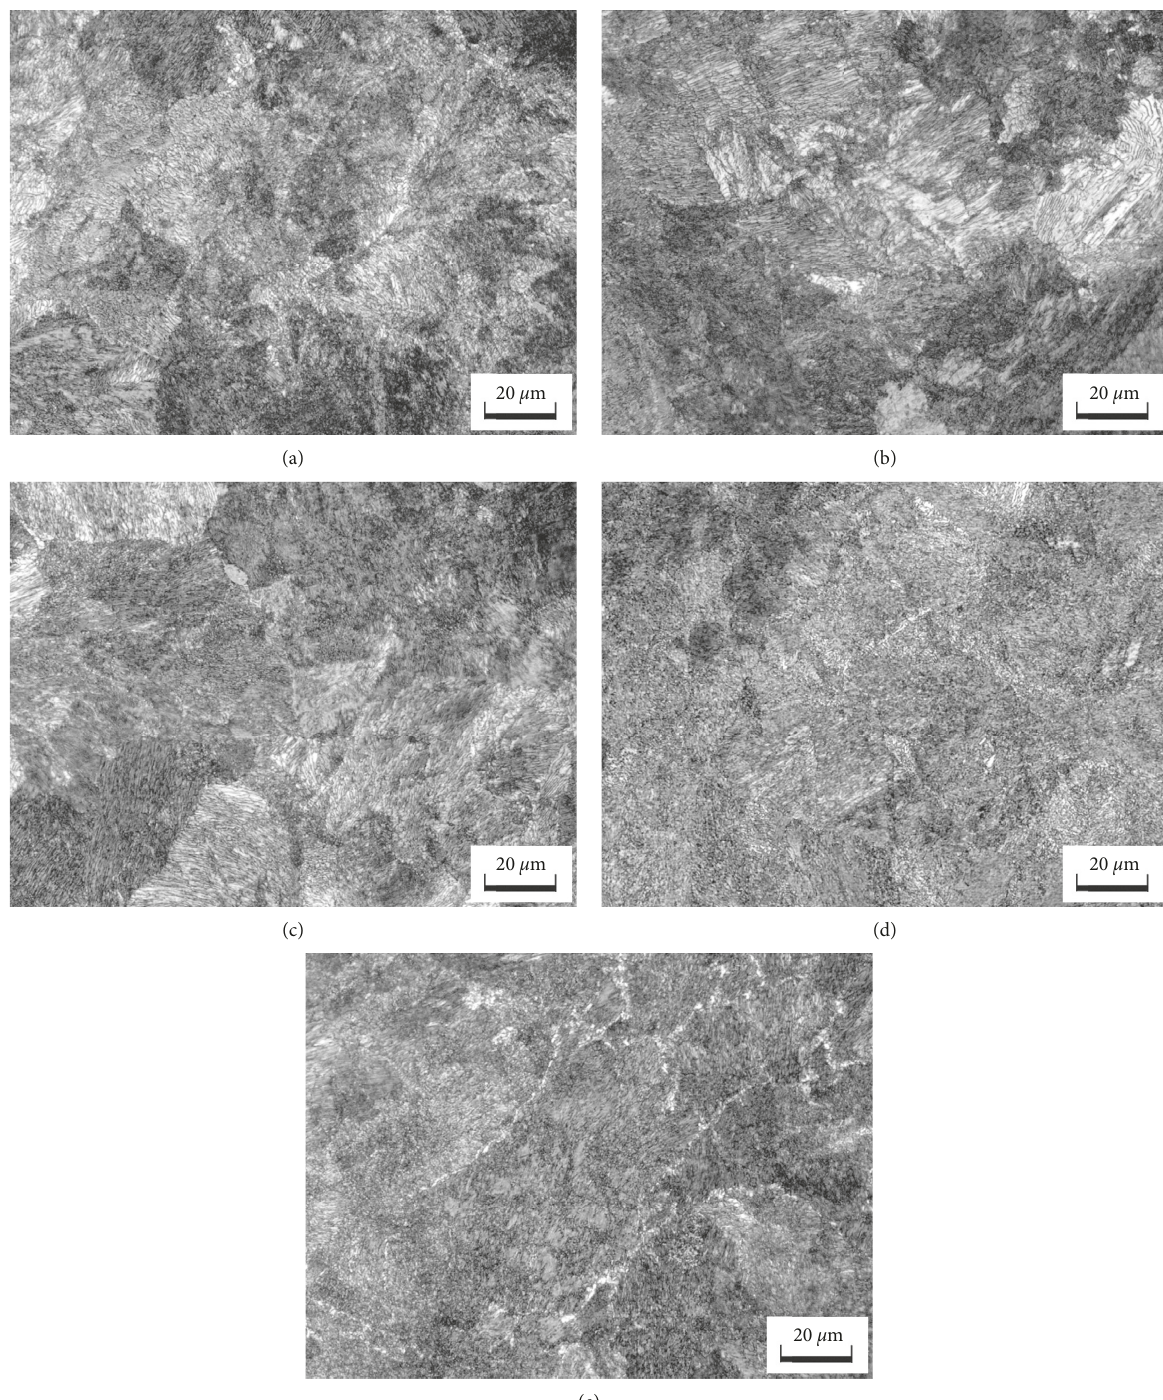
Figure 8: Microstructure of U71Mn rail steel at different experimental temperatures and a strain rate of 0.0005s − 1 . (a) Experimental temperature: 25 ° C. (b) Experimental temperature: 200 ° C. (c) Experimental temperature: 400 ° C (d) Experimental temperature: 600 ° C. (e) Experimental temperature: 800 °